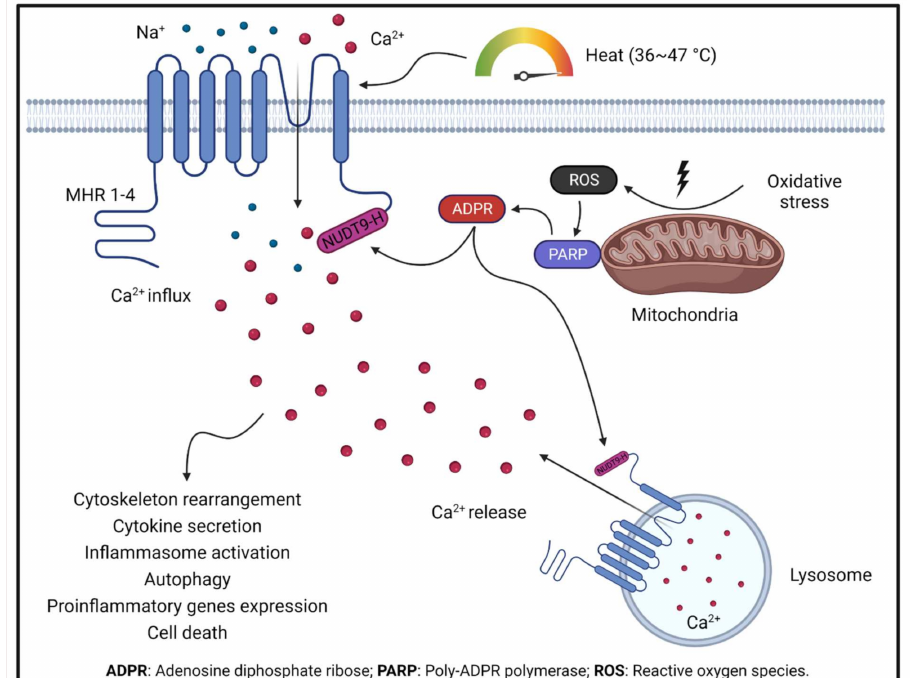
Figure 2. TRPM2 activation by oxidative stress and TRPM2-mediated Ca 2+ signaling under oxidative stress boosts ROS production in mitochondria. Increased ROS production activates PARP, which produces ADPR, a potent endogenous TRPM2 activator. ADPR activates TRPM2 by binding to the NUDT9-H domain at the C terminus. TRPM2 activation leads to Ca 2+ influx from the extracellular en- vironment and Ca 2+ release from lysosomes. TRPM2-mediated Ca 2+ signaling is critical in regulating a series of cellular